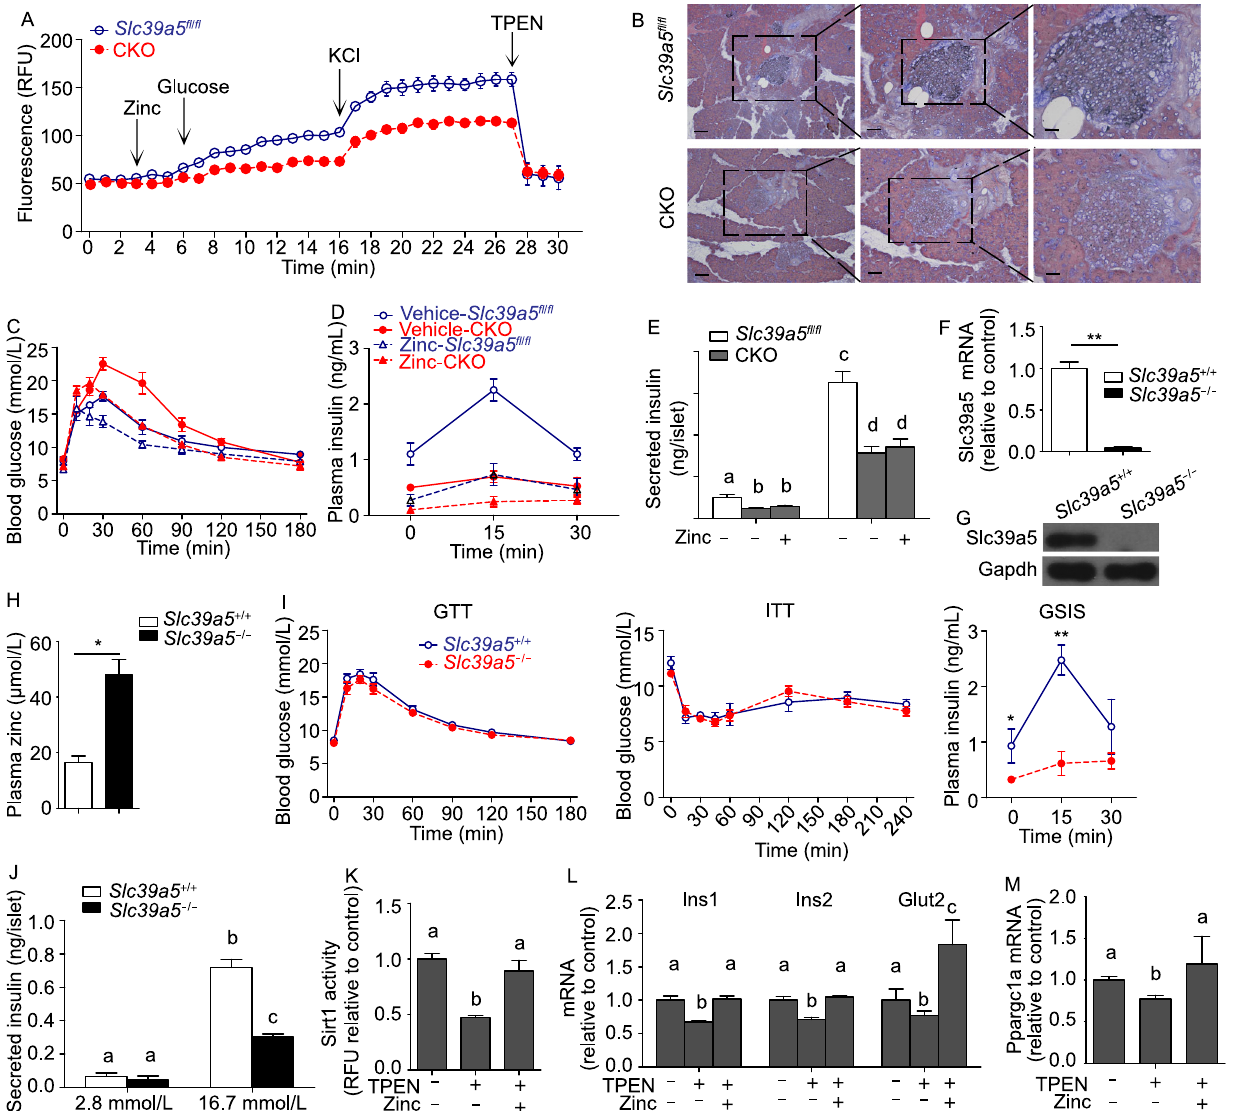
Figure 5. Slc39a5 de fi ciency reduces zinc, Ppargc1a expression and insulin secretion. (A) Time course of zinc content measured in pancreatic islets isolated from Slc39a5 fl / fl and CKO mice and loaded with the fl uorescent zinc indicator FluoZin-3AM. Where indicated, ZnCl 2 (10 μ mol/L), glucose (16.7 mmol/L), KCl (30 mmol/L), and TPEN (10 μ mol/L) were applied ( n = 5 mice